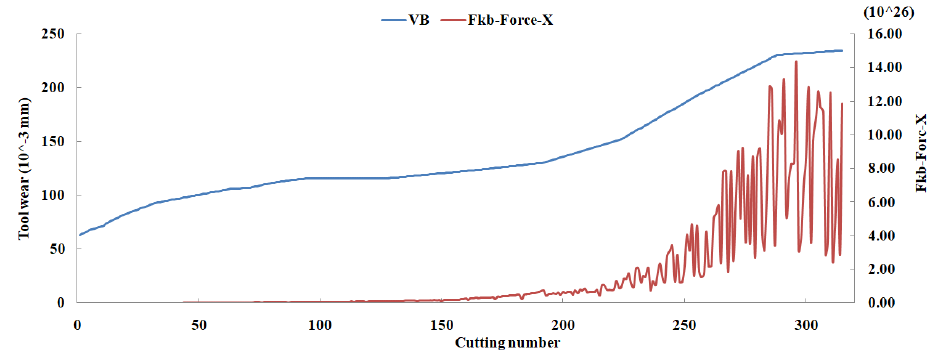
Figure 10. The scatter diagram between F sb in X-dimension Force and tool wear value.